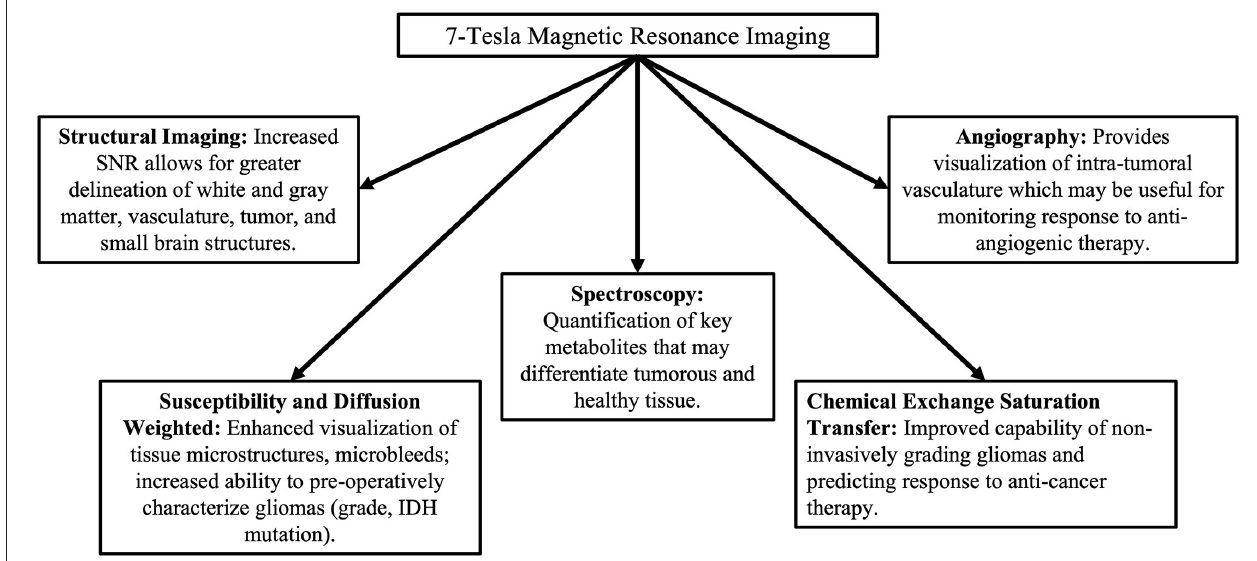
FIGURE 1 | Types of advanced imaging techniques and their benefits in comparison to lower-field